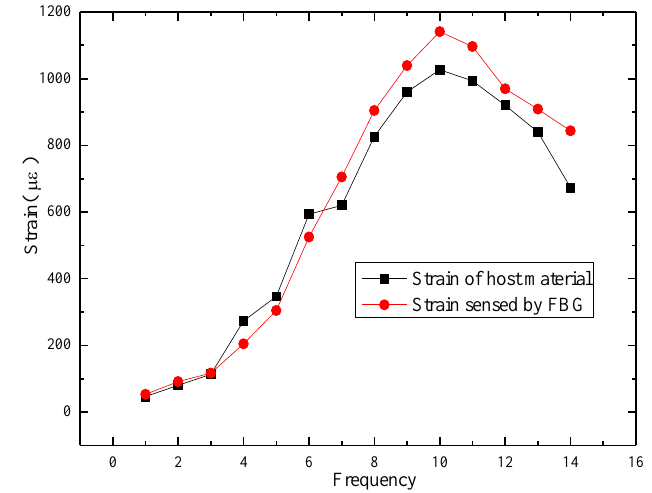
Figure 7. Strain detected by the FBG and the dial indicator.